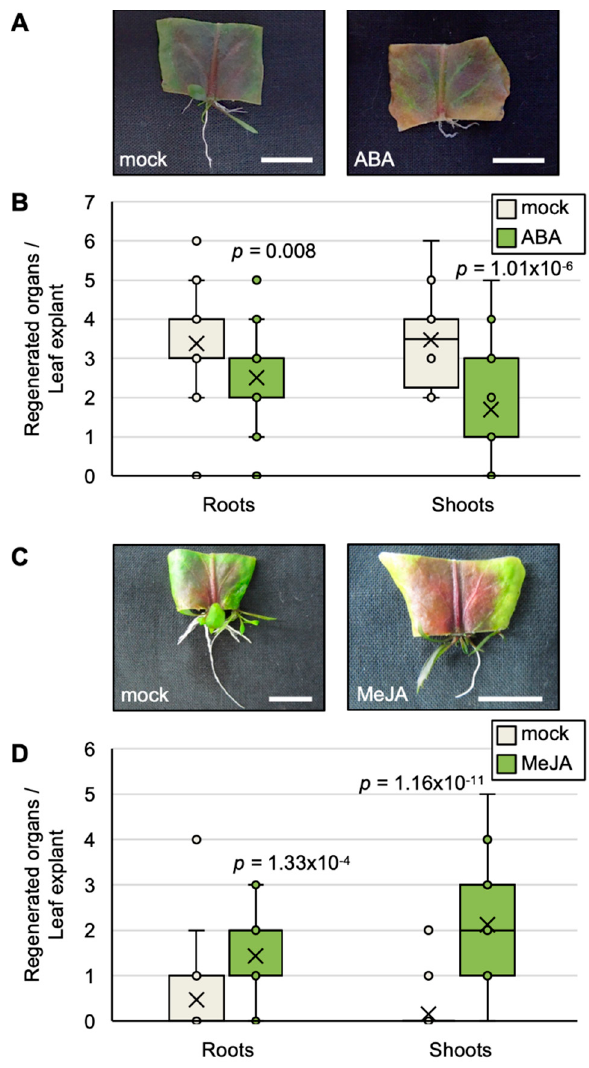
Figure 6. Effects of the exogenous application of abscisic acid (ABA) and jasmonic acid (JA) on vegetative propagation in R. aquatica . ( A , B ) Effect of ABA on vegetative propagation in R. aquatica . ( A ) Leaf fragments cultured on agar medium containing 50 µM ABA at day 22. ( B ) Quantification of regenerated roots and shoots at day 22 ( n = 32) ( B ). The vertical line and horizonal line indicate the number of regenerated organs per leaf explant, and roots or shoots, respectively. ( C , D ) Effect of JA on vegetative propagation in R. aquatica . ( C ) Leaf fragments cultured on agar medium containing 5 µM methyl jasmonate (MeJA) at day 22. ( D ) Quantification of regenerated roots and shoots at day 22 ( n = 32) ( D ). The vertical line and horizonal line indicate the number of regenerated organs per leaf explant, and roots or shoots, respectively. Scale bars = 1 cm. Mock is dimethyl sulfoxide (DMSO). The average value is indicated by a cross mark in each box plot. Significant differences were determined by Student’s t -test and p values indicate exact values.